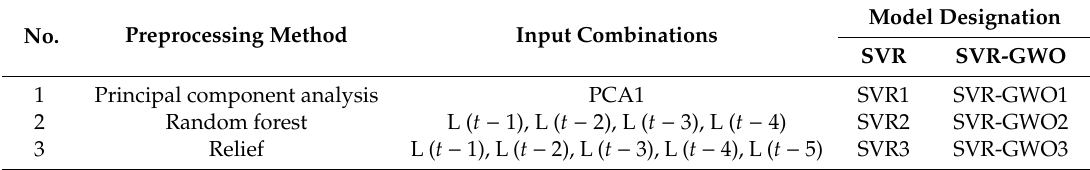
Table 3. Scenarios defined according to the selected input variables by PCA, RF, and RL pre-processing methods.